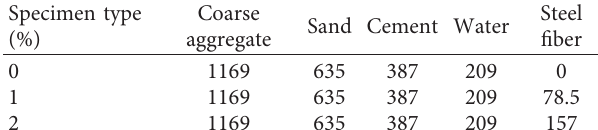
Table 1: The mix design of steel fiber concrete (kg/m 3 ).